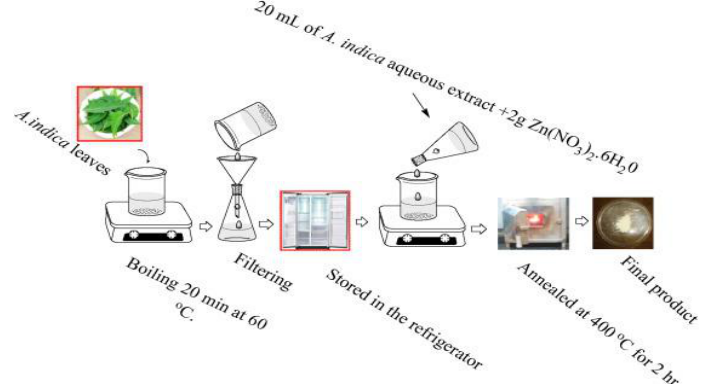
Figure 12. Biosynthesis of ZnO nanoparticles using Zn(NO 3 ) 2 .6H 2 O and the leaf extract of Azadirachta indica . Reproduced from [95] with permission of Elsevier.